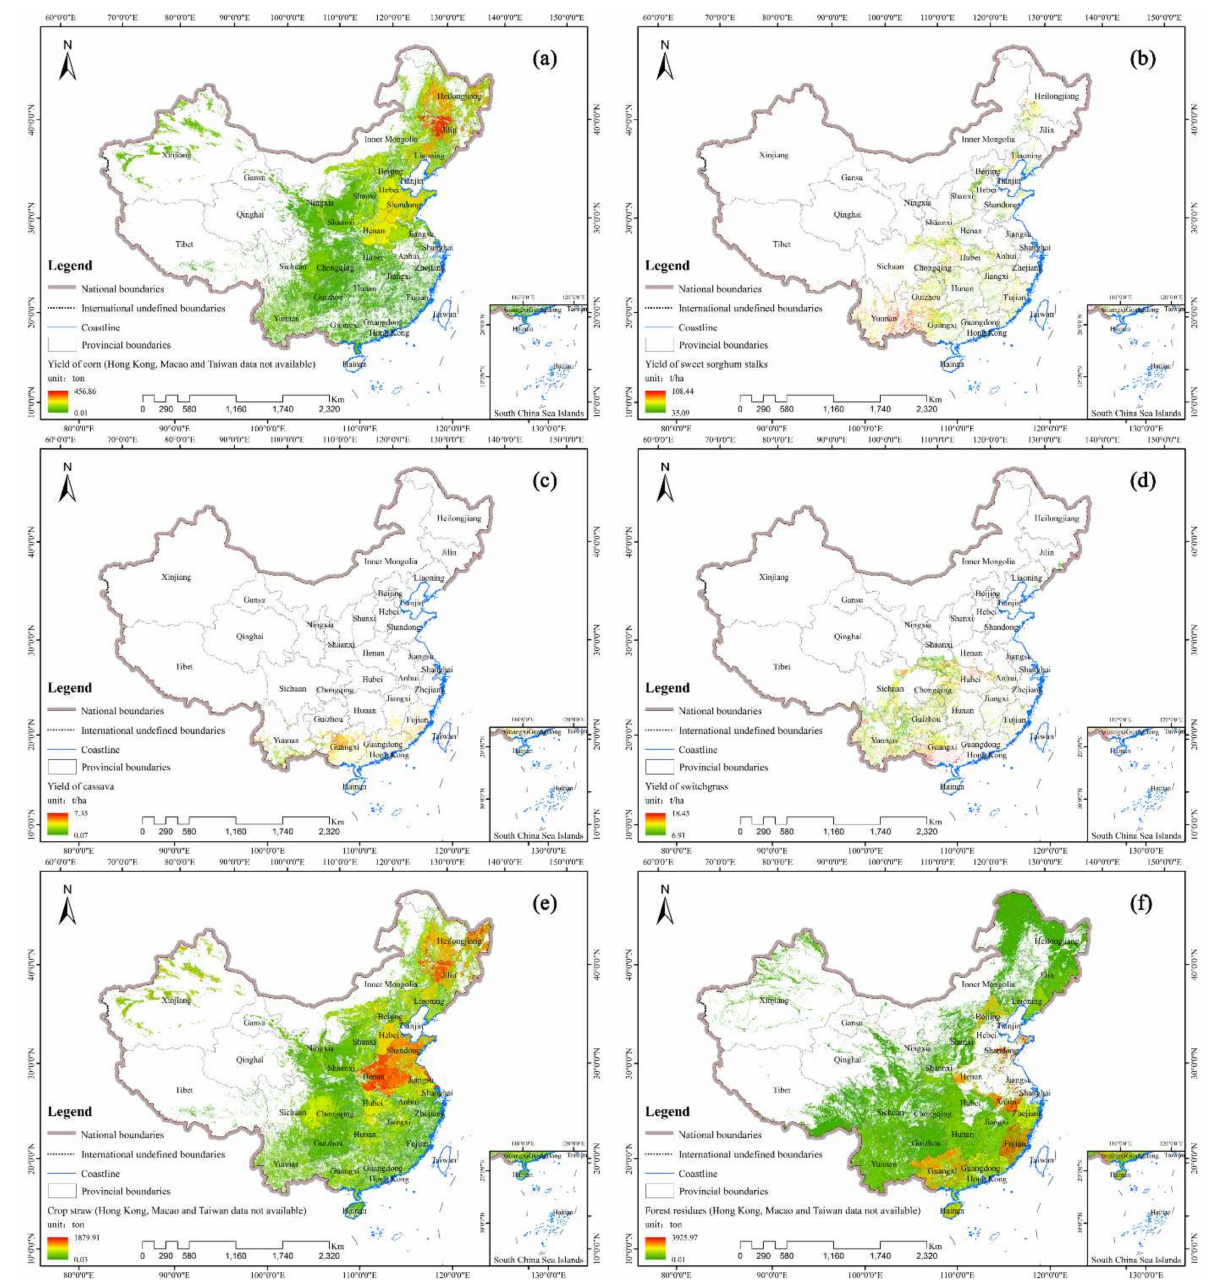
Figure 2. The distribution of bioethanol feedstock resources in China: ( a ) corn yield; ( b ) sweet sorghum stalk yield; ( c ) cassava biomass; ( d ) switchgrass biomass; ( e ) crop straw yield; ( f ) forest residue